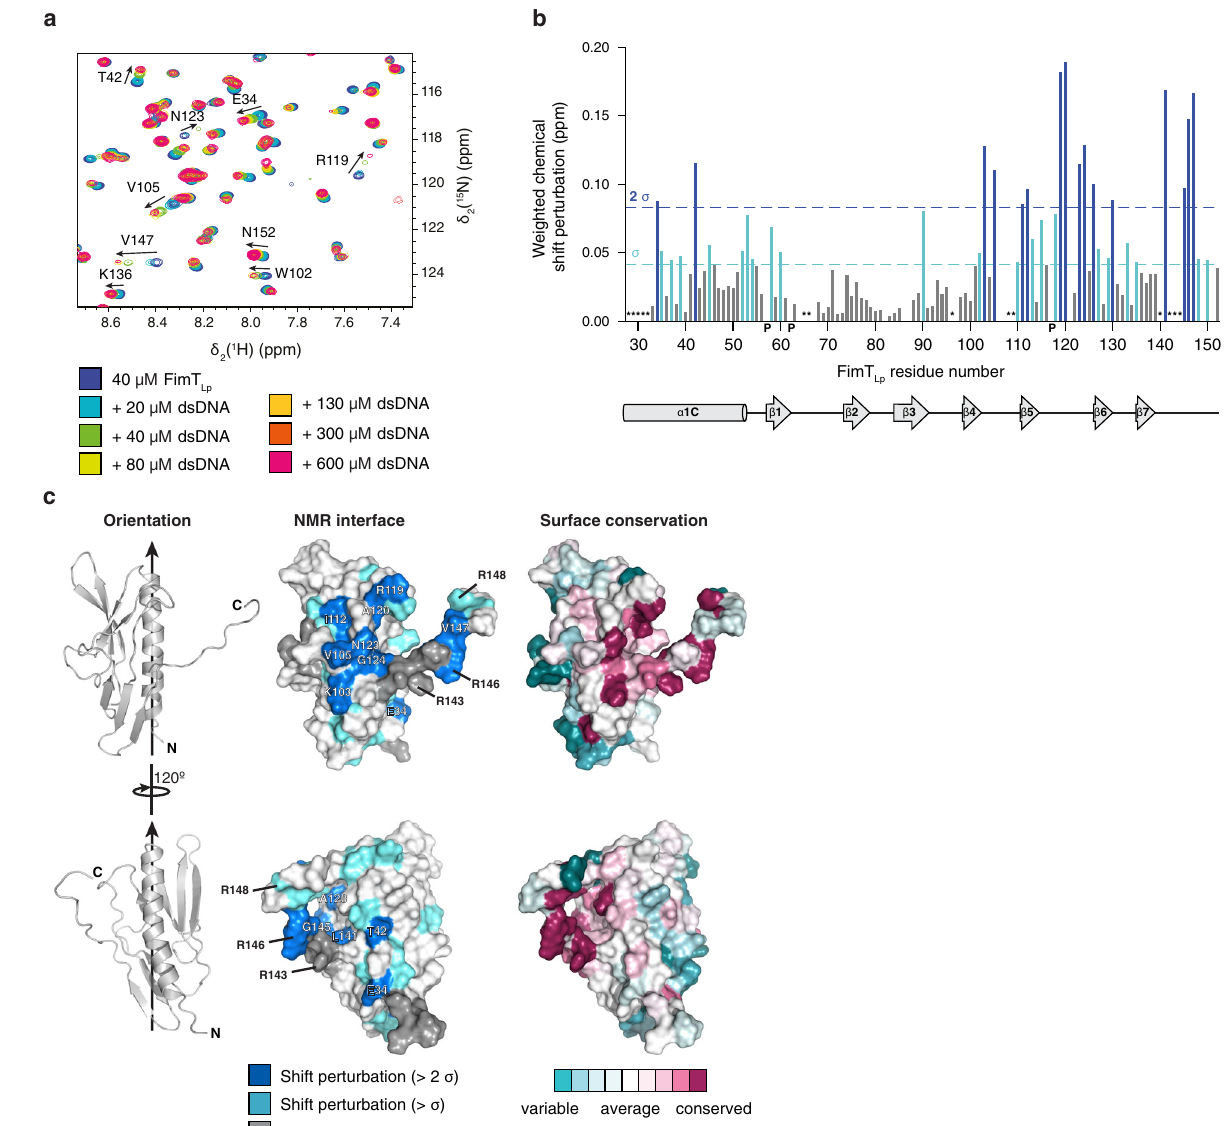
Fig. 3 Identi fi cation of the DNA interaction surface of FimT Lp . a , Selected region of 1 H, 15 N-HSQC spectra showing 15 N-labelled FimT Lp alone and in the presence of increasing concentrations of 12 bp dsDNA. b , Weighted CSP map generated from a. Residues experiencing CSPs ( Δ ppm > 1 σ ), light blue; residues experiencing CSPs ( Δ ppm > 2 σ ), dark blue; P, prolines; *, residues not assigned. c , Left, FimT Lp is shown in two orientations rotated by 120° in ribbon representation. Arrows indicate the pilus axis as in Fig. 2a. Middle, CSPs are mapped onto the surface of FimT Lp and coloured as in b. Residues producing large shifts are labelled on the molecular surface. Right, surface residues of FimT Lp are coloured according to conservation. This image was generated using the ConSurf server 84 . Source data are provided as a Source Data fi